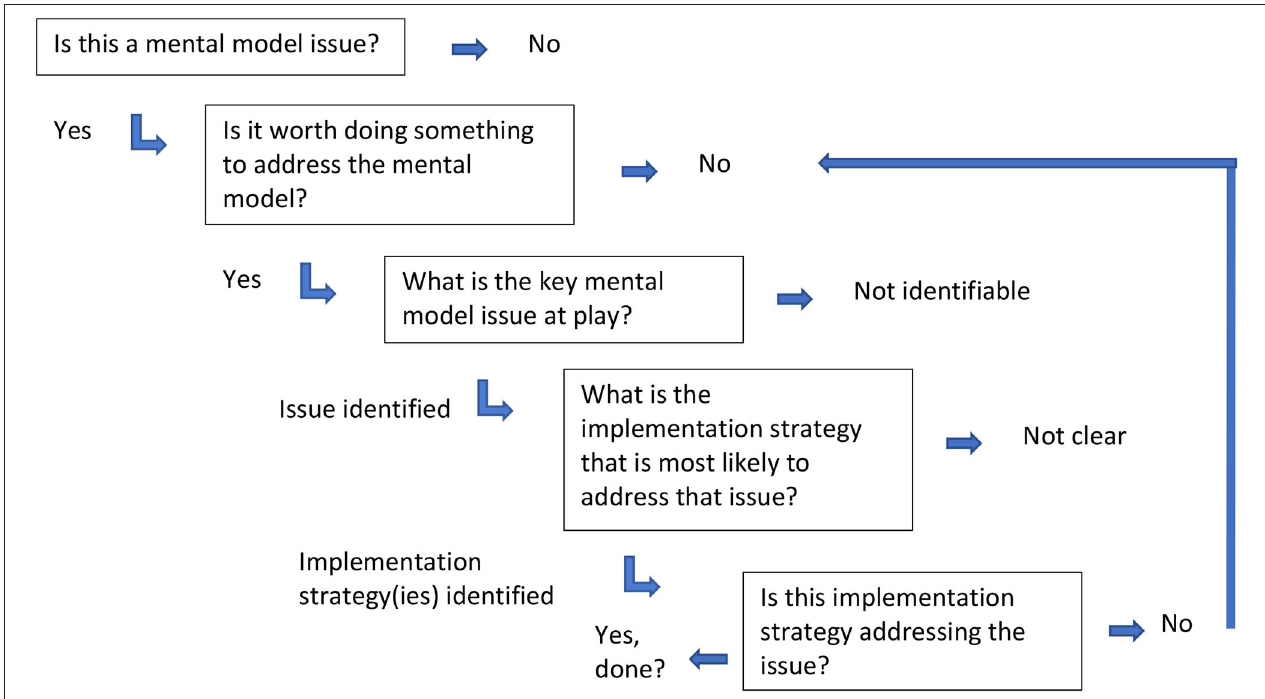
FIGURE 3 | Mental model consideration